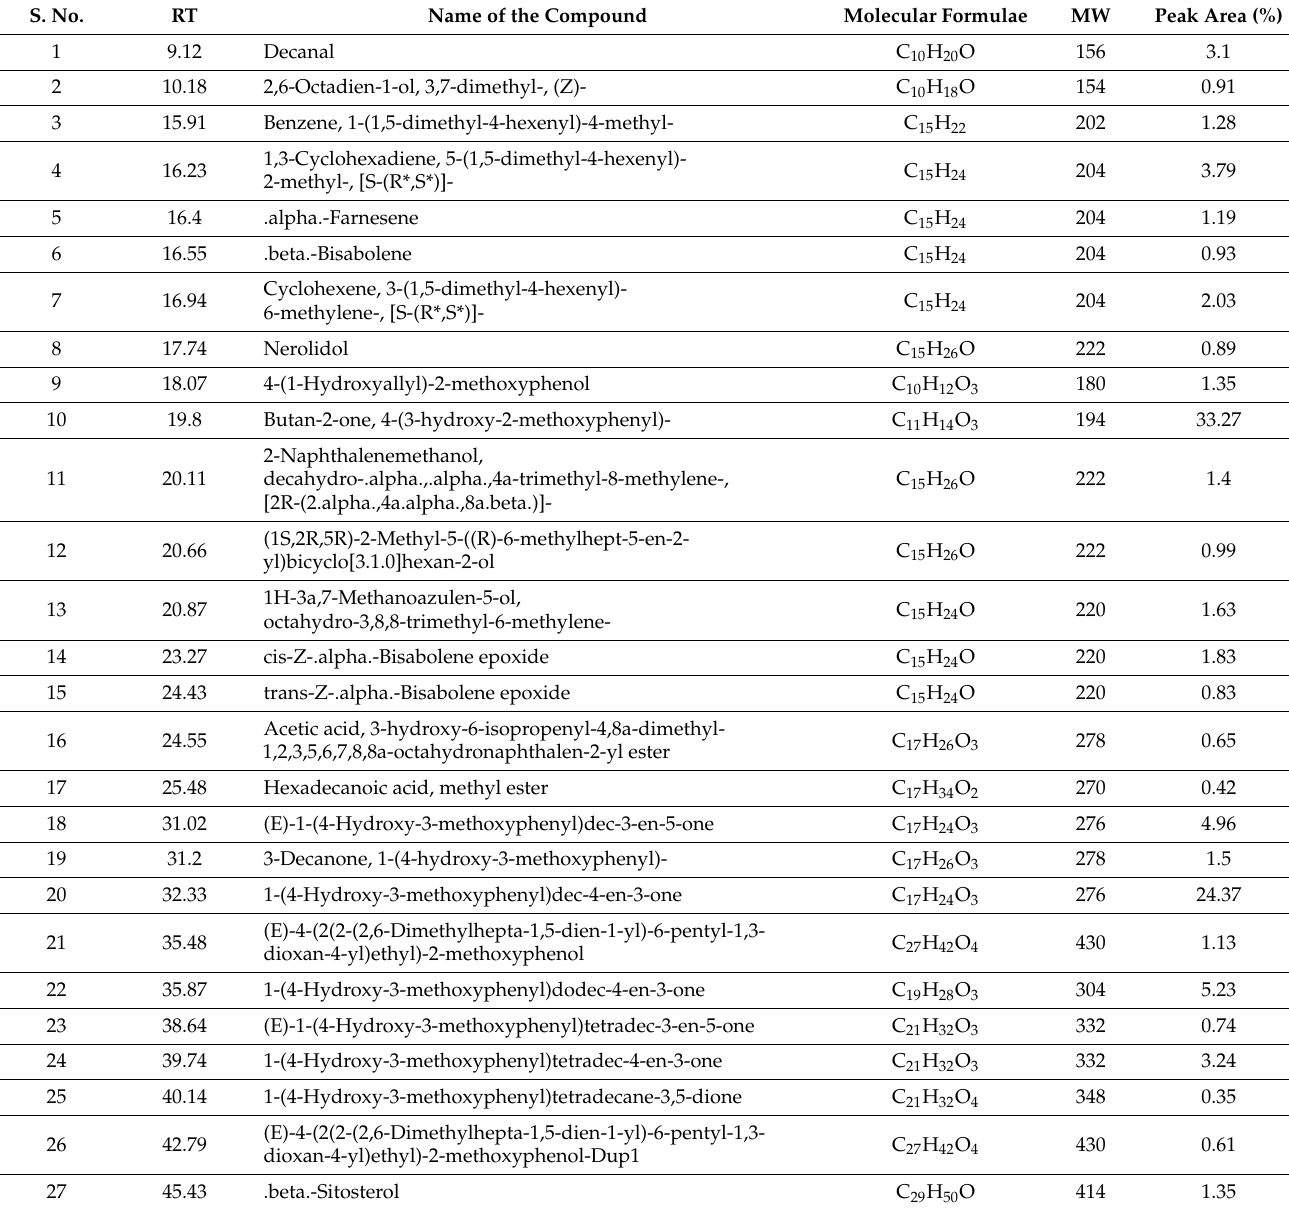
Table 9. Compounds are identified in ethanolic-extracted Z. officinale